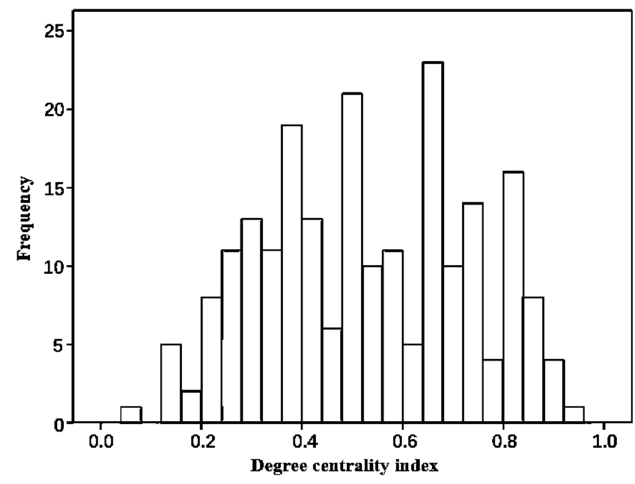
Figure 4. Frequency distribution of the degree centrality index.